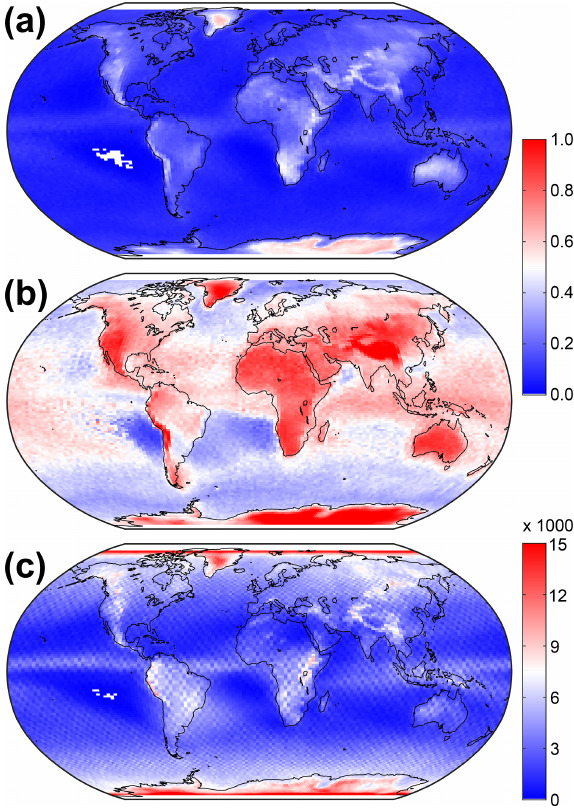
Figure 4. Global distribution of (a) the ratio of CALIPSO profiles that contain transparent altocumulus in the absence of opaque low- level clouds versus all cloudy profiles, (b) the ratio of CALIPSO profiles that contain transparent altocumulus in the absence of opaque low-level clouds versus all cloudy profiles that contain this cloud type, and (c) the number of cloudy profiles per grid box that contain transparent altocumulus.